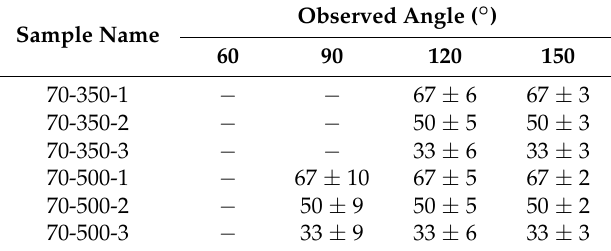
Table 3. Determined relative concentration ratio (wt.%) of W15BG001 in a mixture of two polyethylene latex